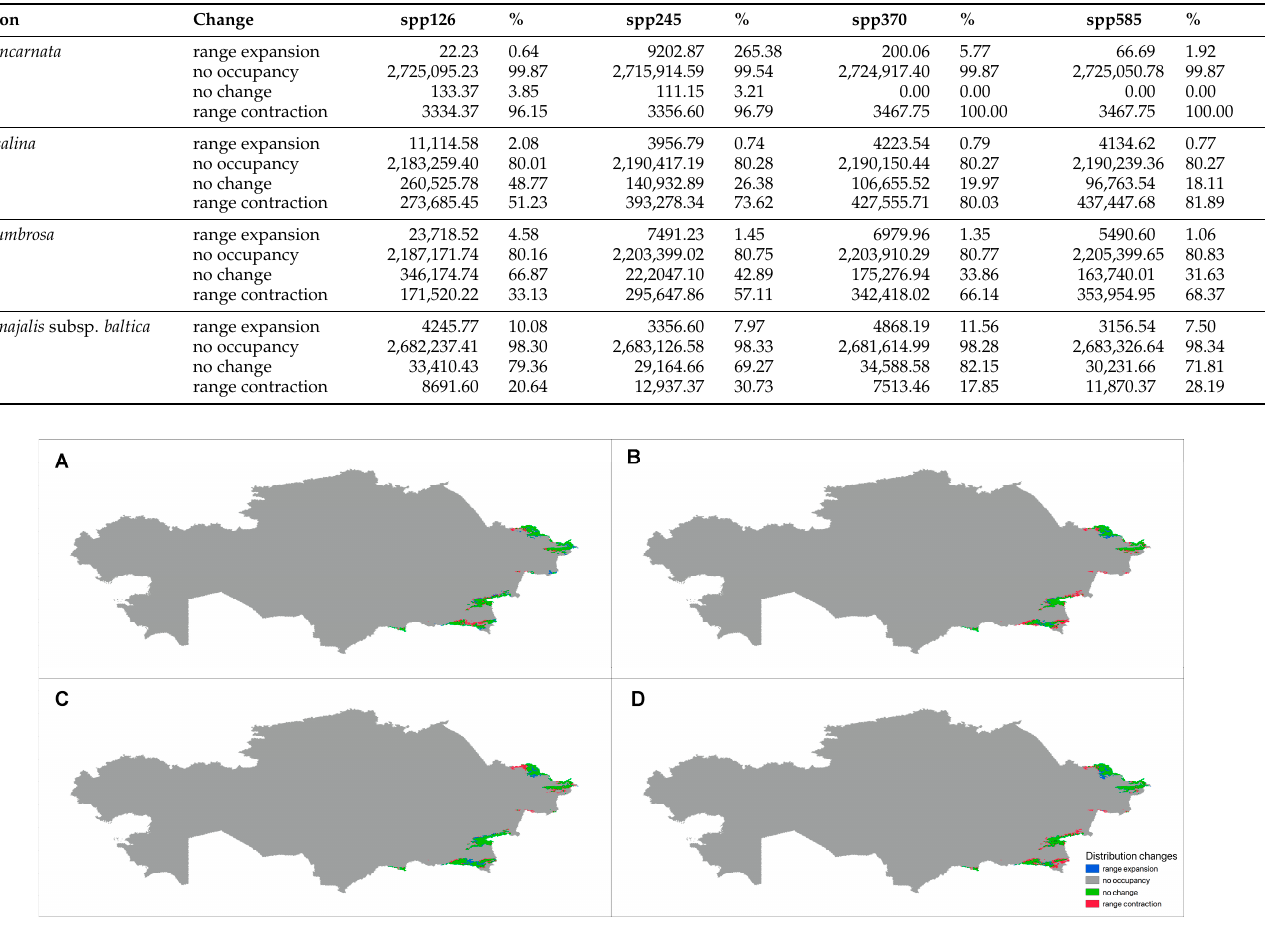
Figure 10. Changes in the distribution of suitable habitats in Kazakhstan for Dactylorhiza majalis subsp. baltica (Klinge) H.Sund. and four climate change scenarios—spp126 ( A ), spp245 ( B ), spp370 ( C ), and spp585 ( D ).